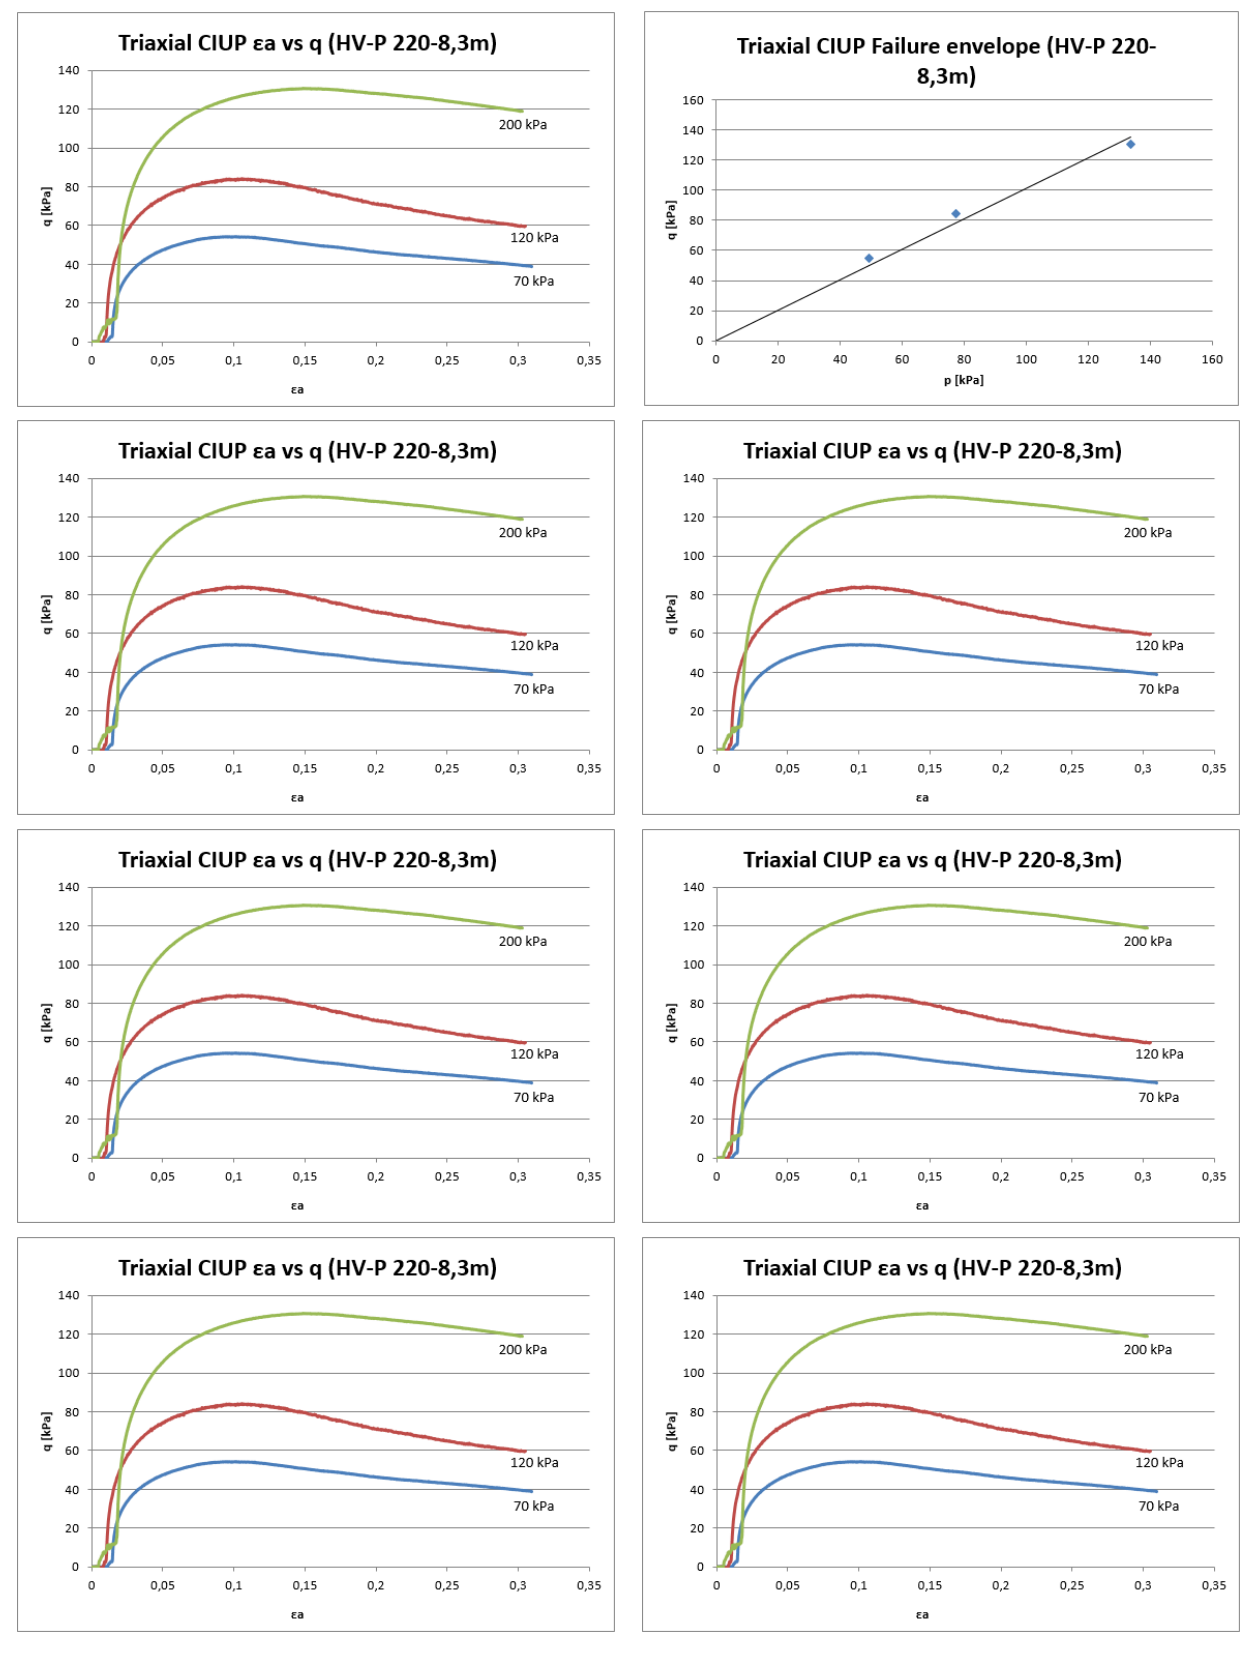
Figure 4. The results of performed